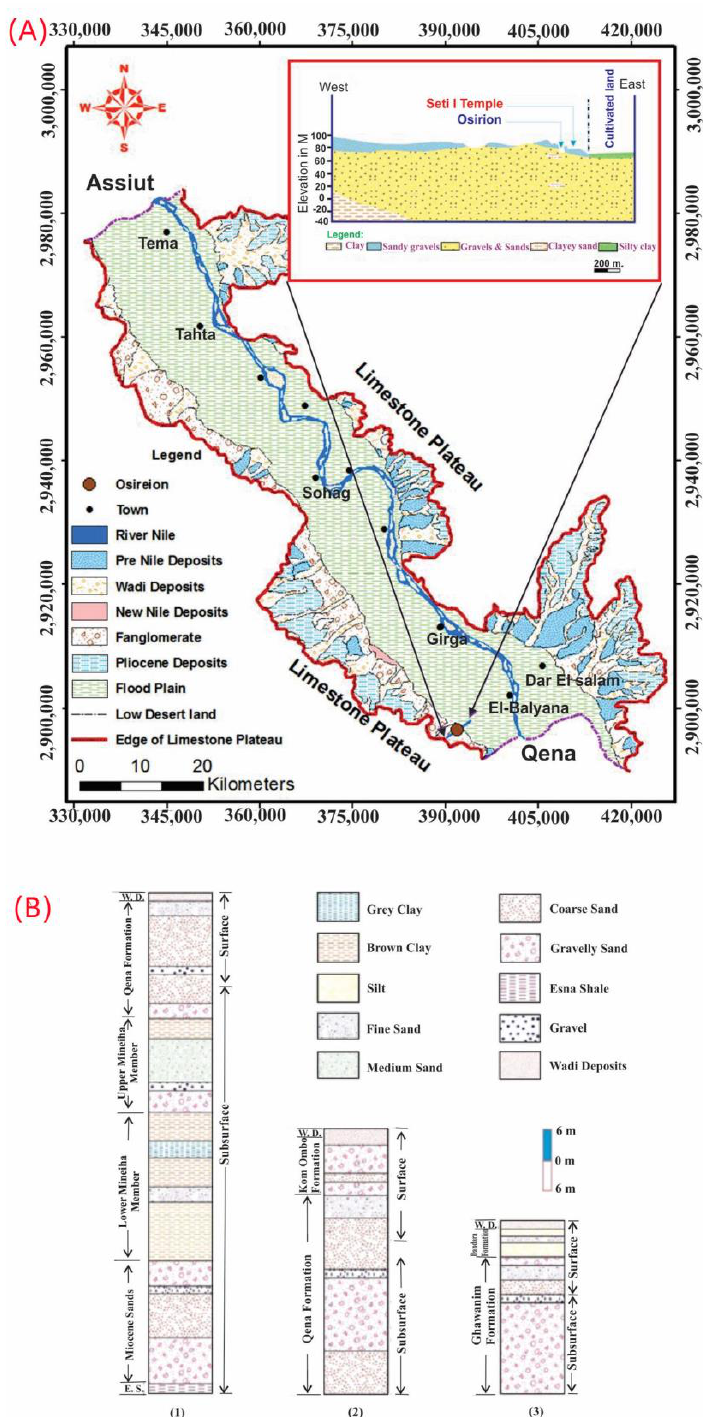
Figure 5. ( A ) Simplified surface geologic map of Sohag Governorate, [59] and cross-section along the study area [58] and ( B ) Three stratigraphic sequence west of Abydos area [54].